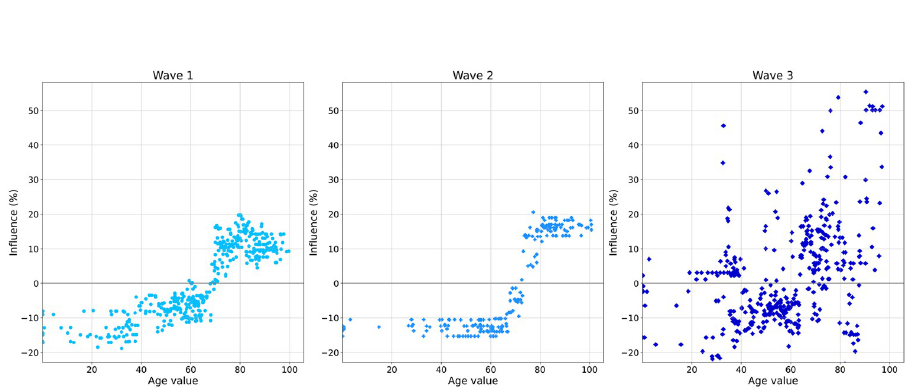
Fig 4. Univariate graph of patient Age effects for each wave. Each dot represents a patient, with age value on the x- axis and the associated influence on the y-axis.